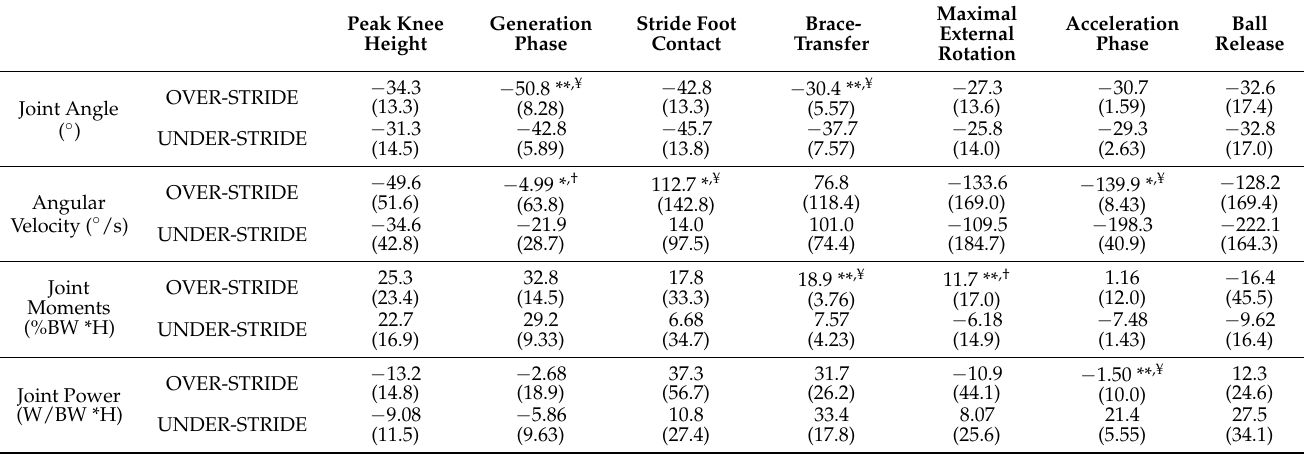
Table 1. Drive knee flexion/extension dynamics.